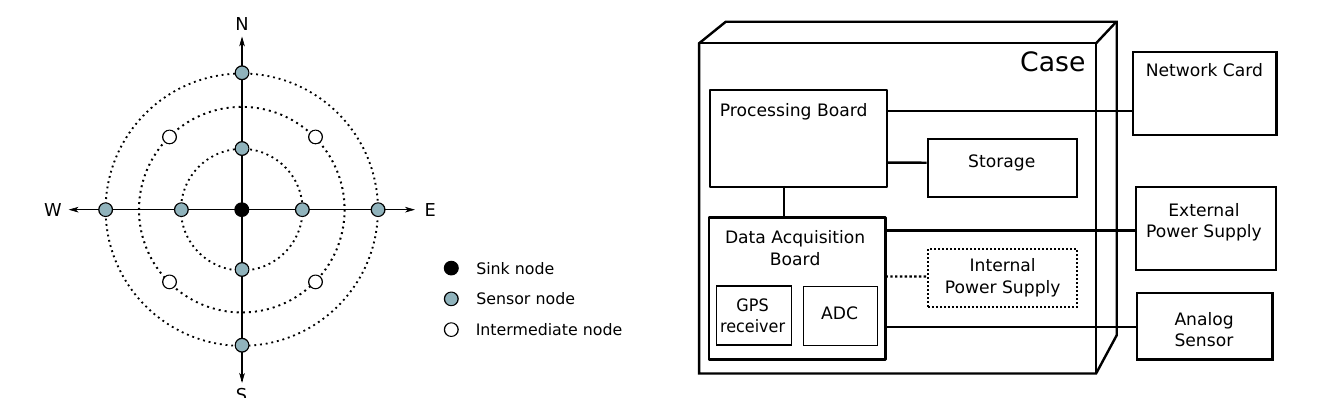
Fig. 3: Node software architecture